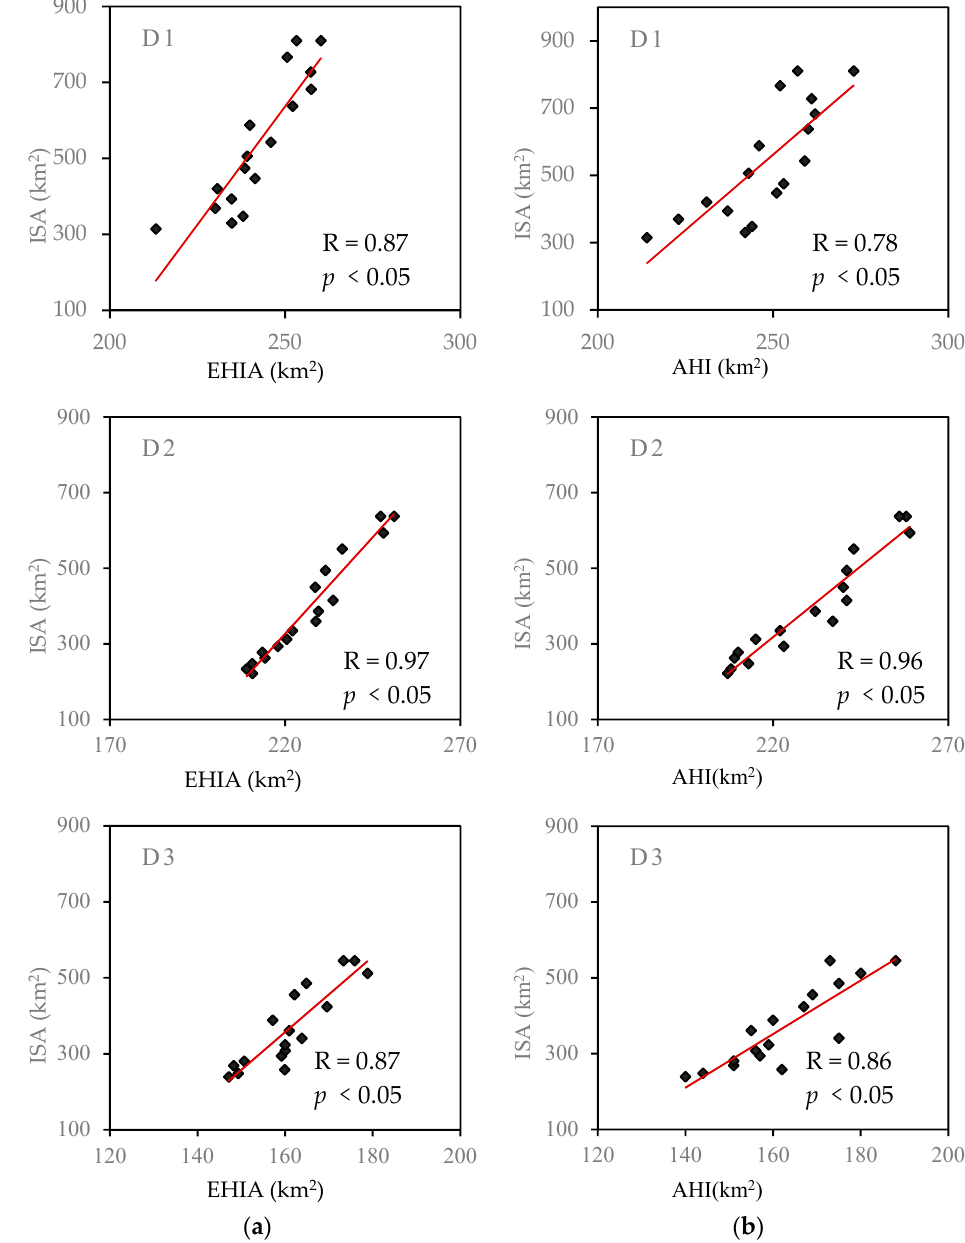
Figure 15. Correlation between the heat island area and impervious surface area (ISA). ( a ) Equivalent heat island area (EHIA) and ISA, and ( b ) average heat island area (AHI) and ISA.